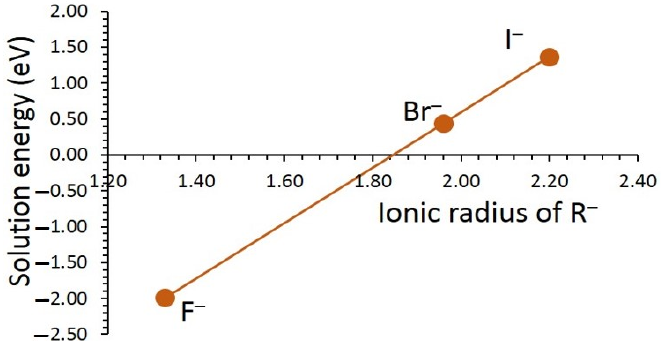
Figure 7. ( a ) Optimized structure of Ge-doped Li 6 SiO 4 Cl 2, ( b ) DOS plot, and ( c ) atomic DOS plot of Ge.